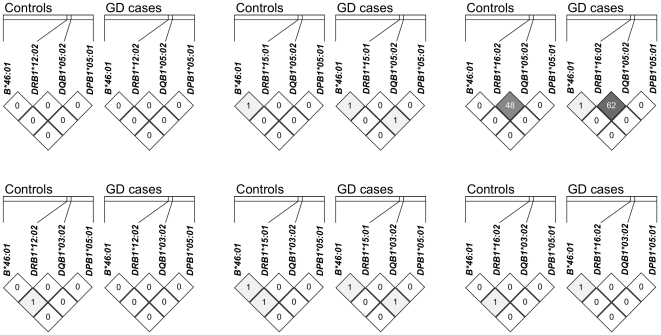
Linkage disequilibrium analysis of HLA-B, HLA-DRB1, HLA-DQB1 and HLA-DPB1 alleles showing significant associations with GD.The distances between consecutive loci are approximately 1225 Kb, 81 kb and 416 Kb respectively. The r2 value (× 100) of any allele pair was plotted inside the corresponding cell. Except for strong linkage disequilibrium (r2 = 0.48 in controls, r2 = 0.62 in cases) between DRB1*16:02 and DQB1*05:02, in general the r2 value between other alleles was quite low.